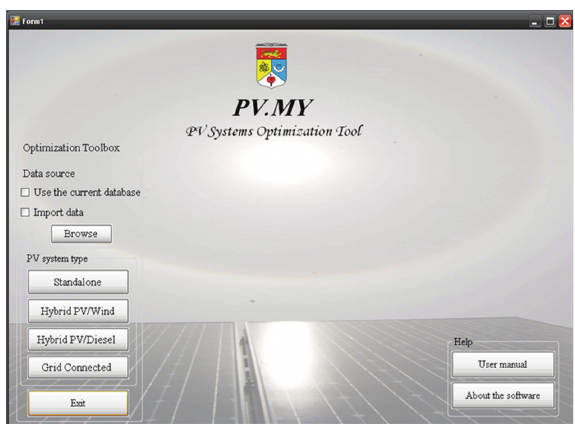
Figure 2: The main page of the PV.MY software tool.